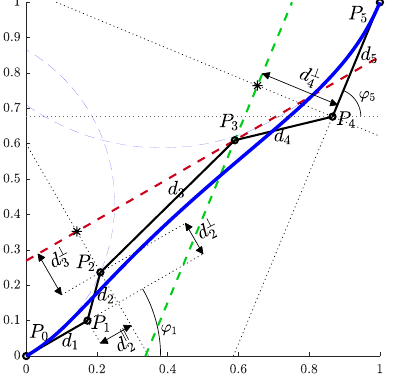
Figure 2. The proposed construction of a Bézier curve that enables efficient